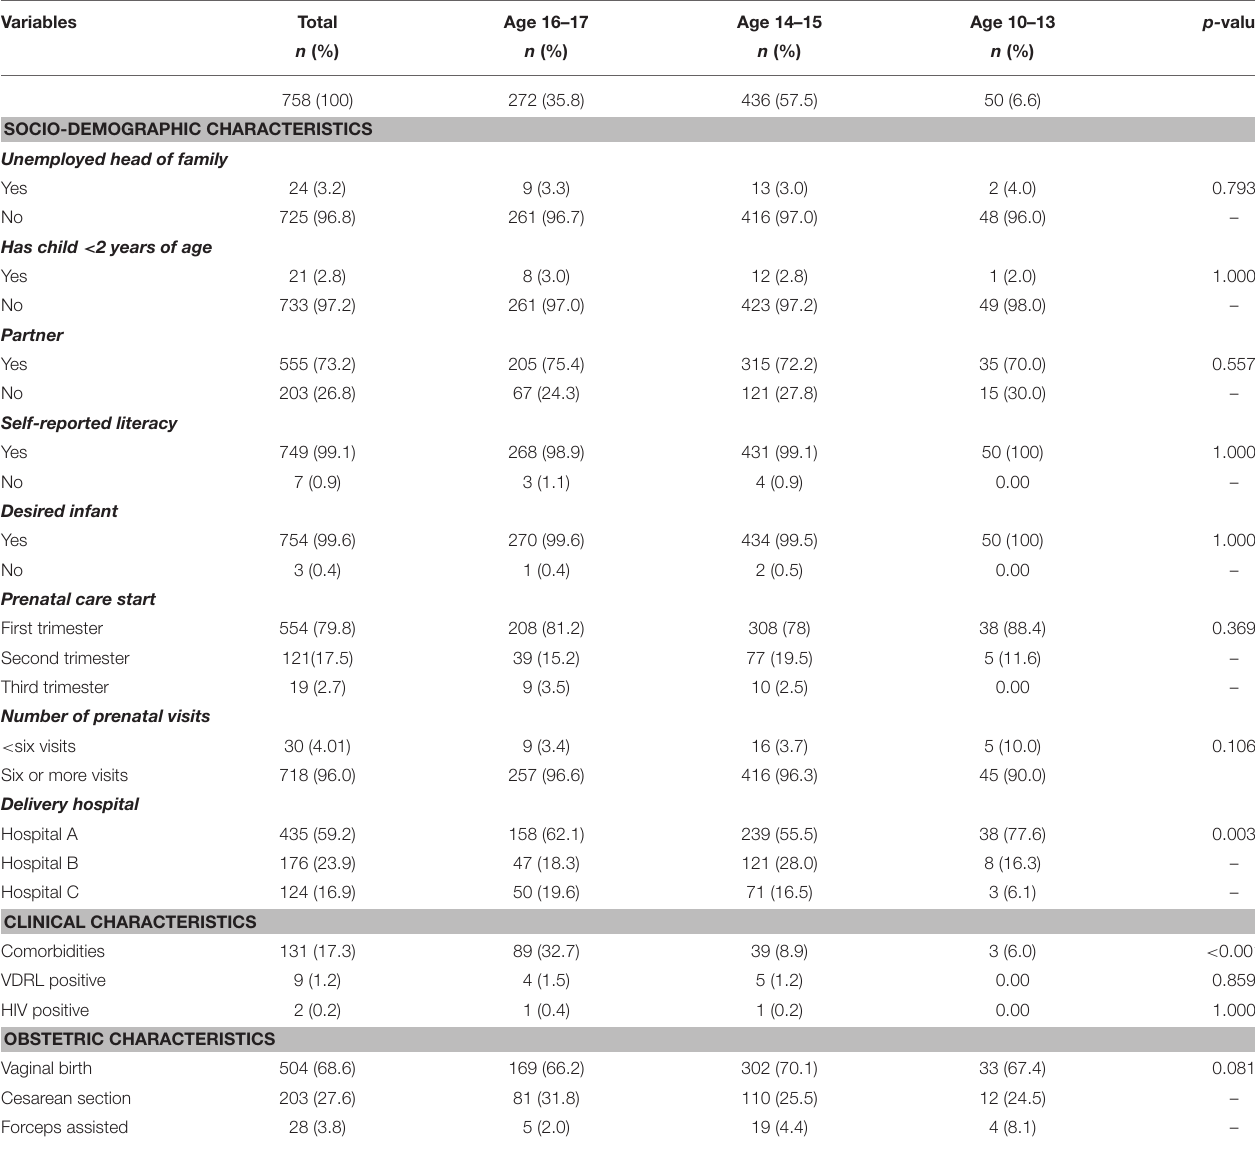
TABLE 1 | Socio-demographic, clinical, and obstetric characteristics of pregnant adolescents who received prenatal care